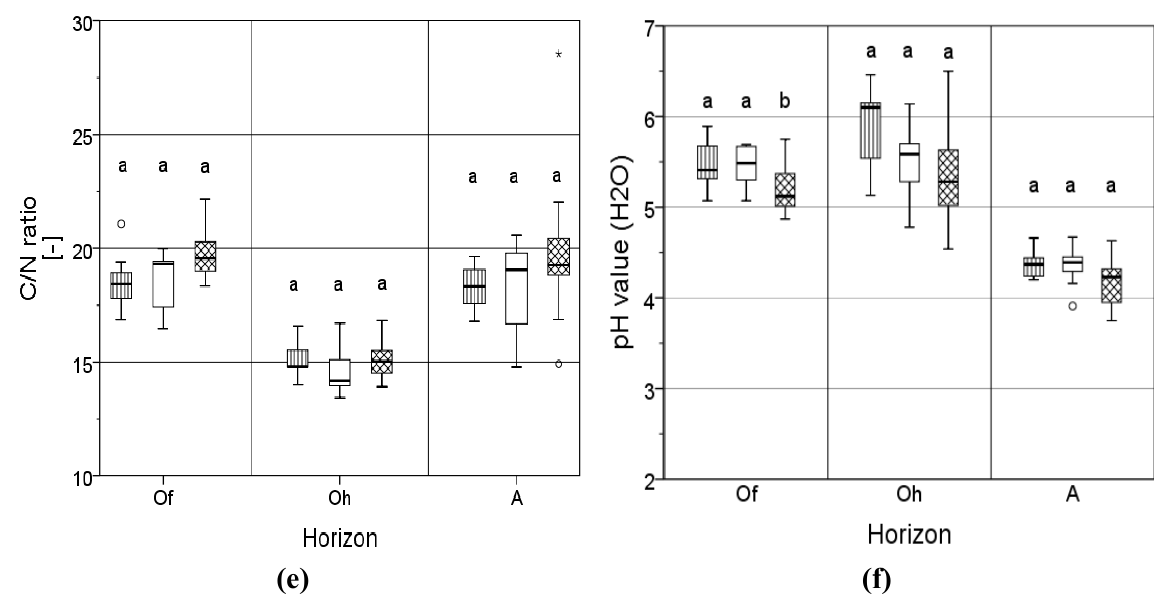
Figure 2. Box-whisker-plots for the tree strata (dashed: birch stratum, white: spruce-birch stratum, chequered: spruce stratum) in the three horizons depicting ( a ) organic C content; ( b ) organic C stock; ( c ) total N content; ( d ) total N stock; ( e ) C/N ratio and ( f ) pH (H 2 O). Different lower case letters indicate significant differences between strata within one horizon ( p <